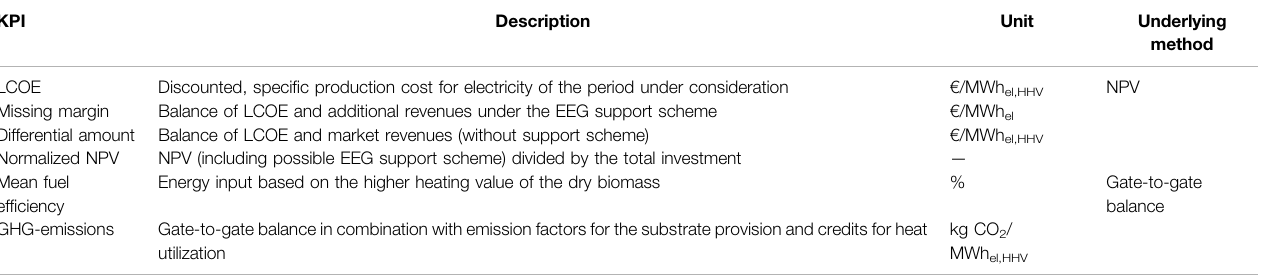
TABLE 5 | Key performance indicators (KPI) for the assessment of follow-up concepts and extended operation of biogas plants. KPI